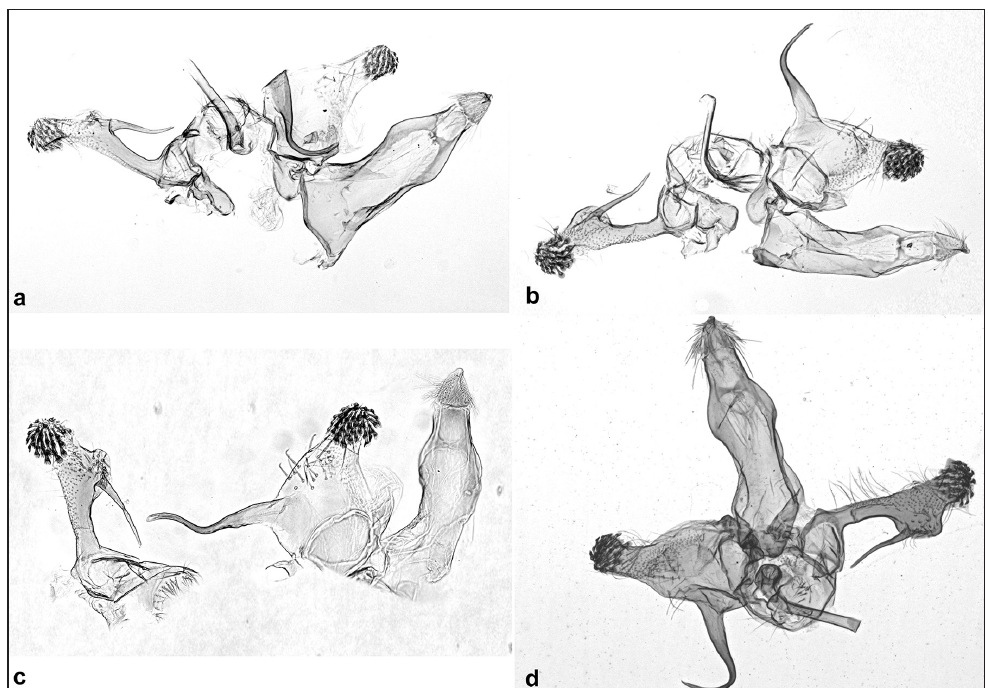
Figure 12. a. Anarsia lineatella, male genitalia, Morocco (KG3365); b. Anarsia lineatella ssp. heratella , male genitalia, holotype (OK5296); c. Anarsia lineatella ssp. tauricella , male genitalia, holotype